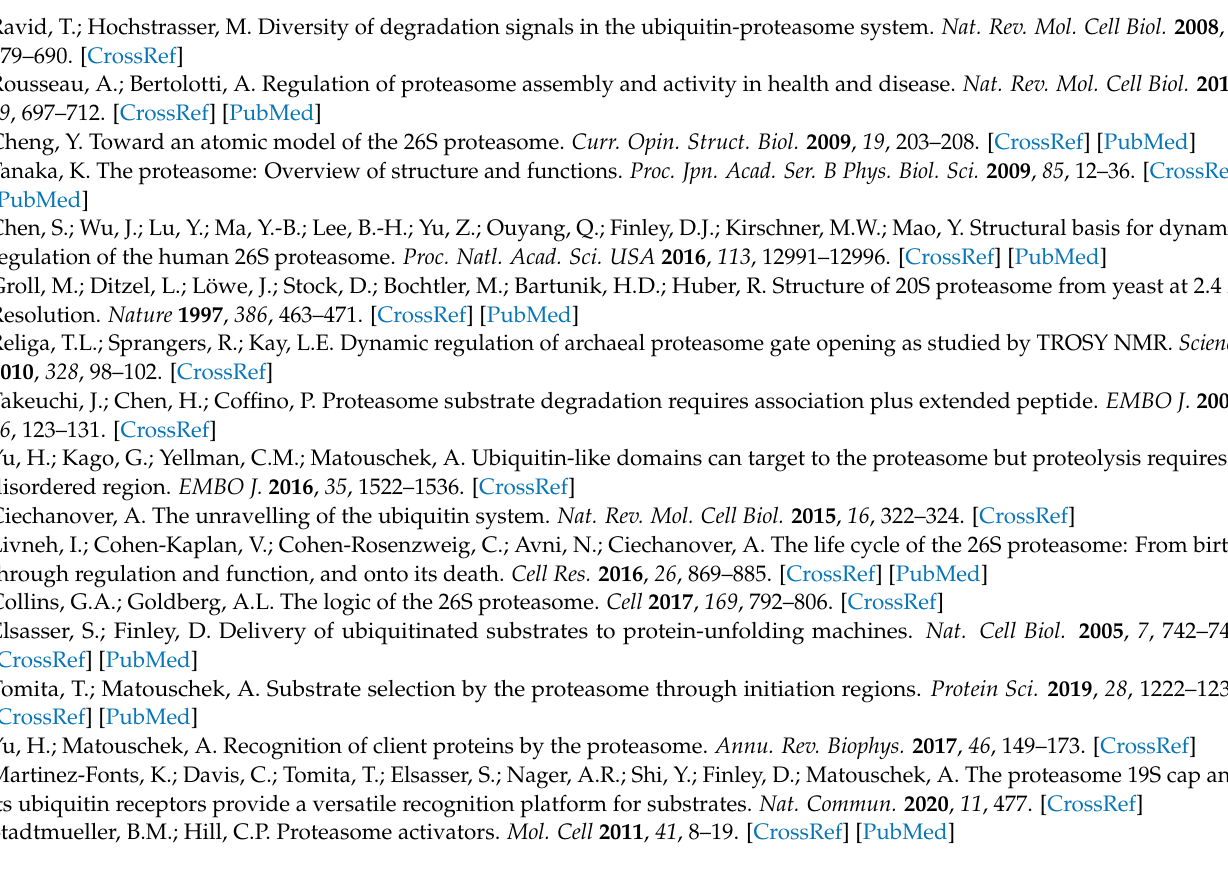
PSMA5 and PSMA3 chimeric constructs. Figure S4: The PSMA3 trapper does not inhibit proteasome catalytic